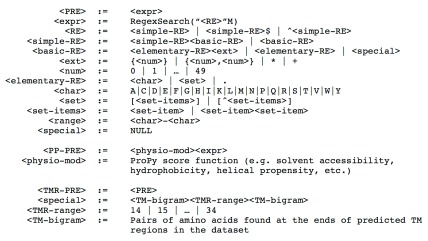
Backus–Naur form grammar for proteins.